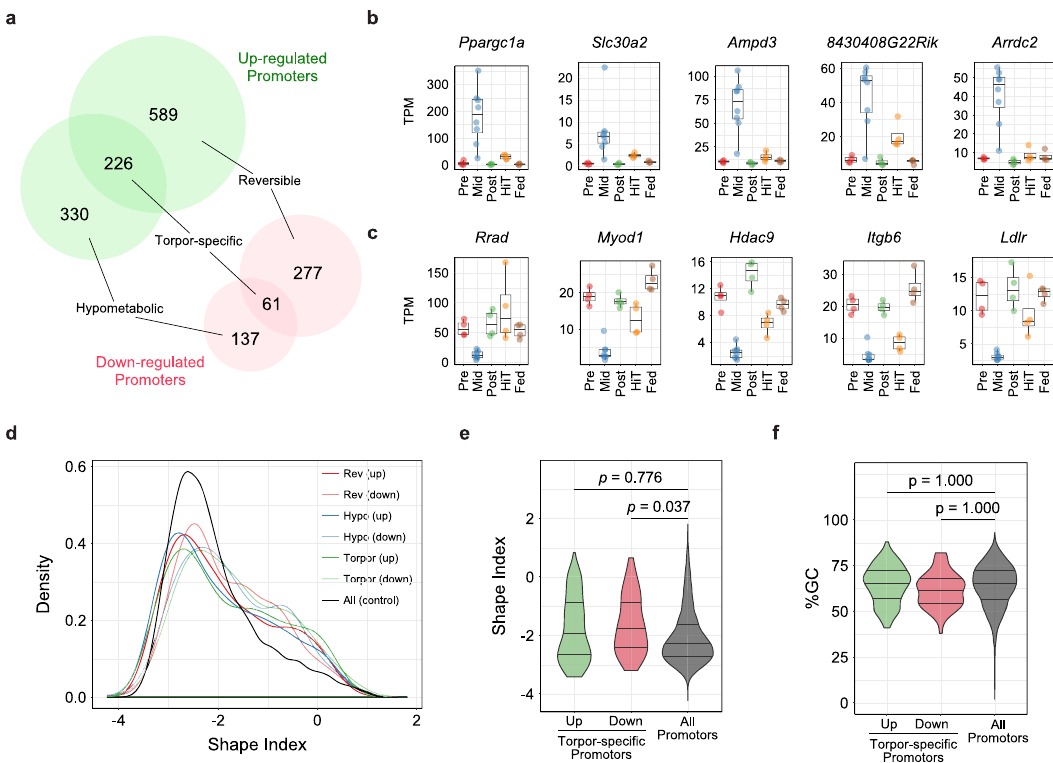
Fig. 3 Identi fi cation of Torpor-speci fi c Promoters and their Dynamics. a Torpor-speci fi c promoters were de fi ned by the intersection of reversible and hypometabolic promoters. Up-regulated torpor-speci fi c promoters ( n = 226), which were CAGE clusters that were highly expressed exclusively during torpor, were at the intersection of the up-regulated reversible ( n = 589) and hypometabolic promoters ( n = 330). Down-regulated torpor-speci fi c promoters ( n = 61), which were CAGE clusters that were highly suppressed exclusively during torpor, were at the intersection of down-regulated reversible ( n = 277) and hypometabolic promoters ( n = 137). b , c Top fi ve up-regulated ( b ) and down-regulated ( c ) torpor-speci fi c promoters ordered according to the sum of the TPM change observed in the reversibility and hypometabolism experiments. Only promoters that had annotated downstream genes are shown. d Distribution of the SI of all of the mouse muscle promoters. An SI of 2 indicates a singleton-shaped CAGE TSS signal, and promoters with SI < − 1 have a broad shape. e, f Distribution of the SI ( e ) or %GC ( f ) for torpor-speci fi c promoters compared to all muscle promoters. The three horizontal lines inside the violin denote the 1st, 2nd, and 3rd quartile of the distribution from the upmost